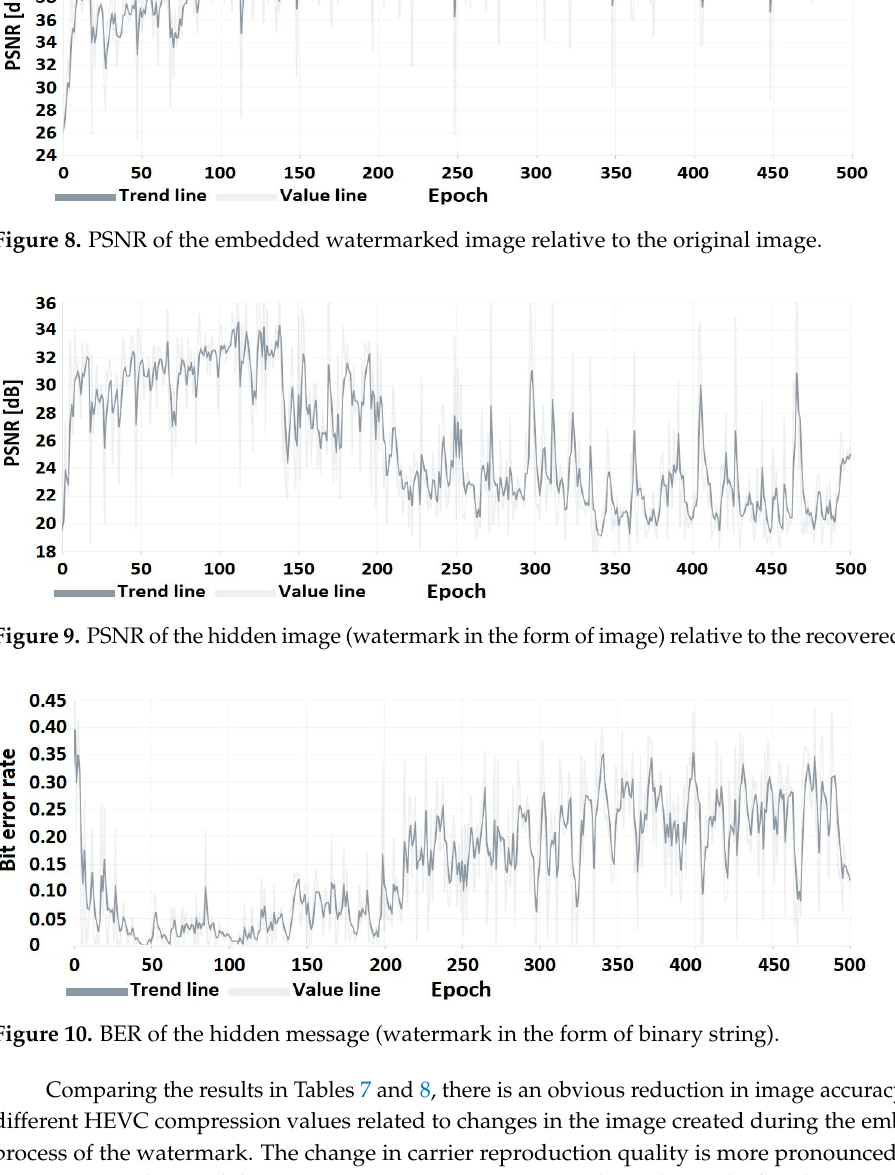
Table 12. Method comparison.